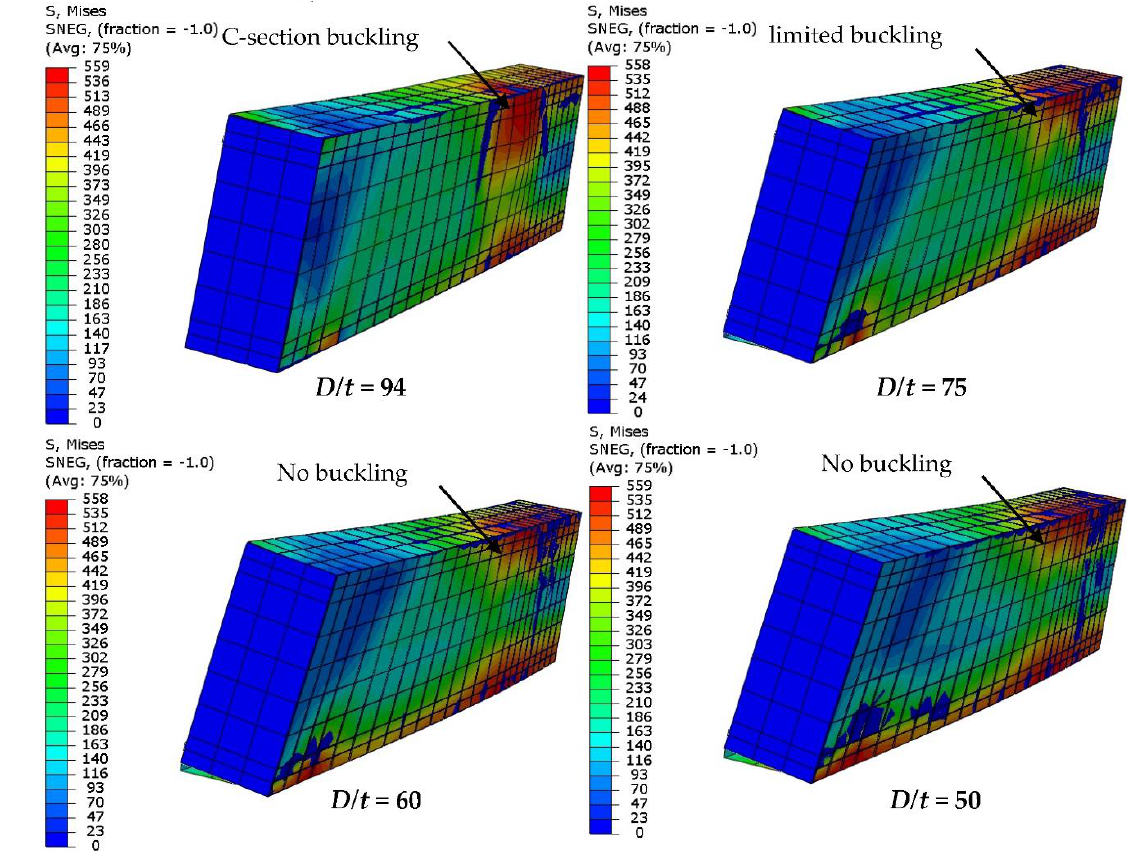
Figure 21. Effects of the D / t ratio on the steel C-section’s buckling behavior.